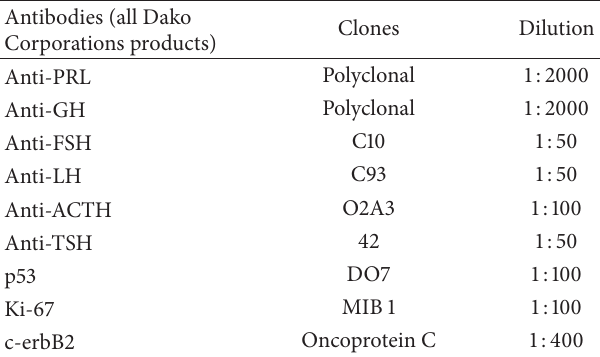
Table 1: Used antibodies, clones, and